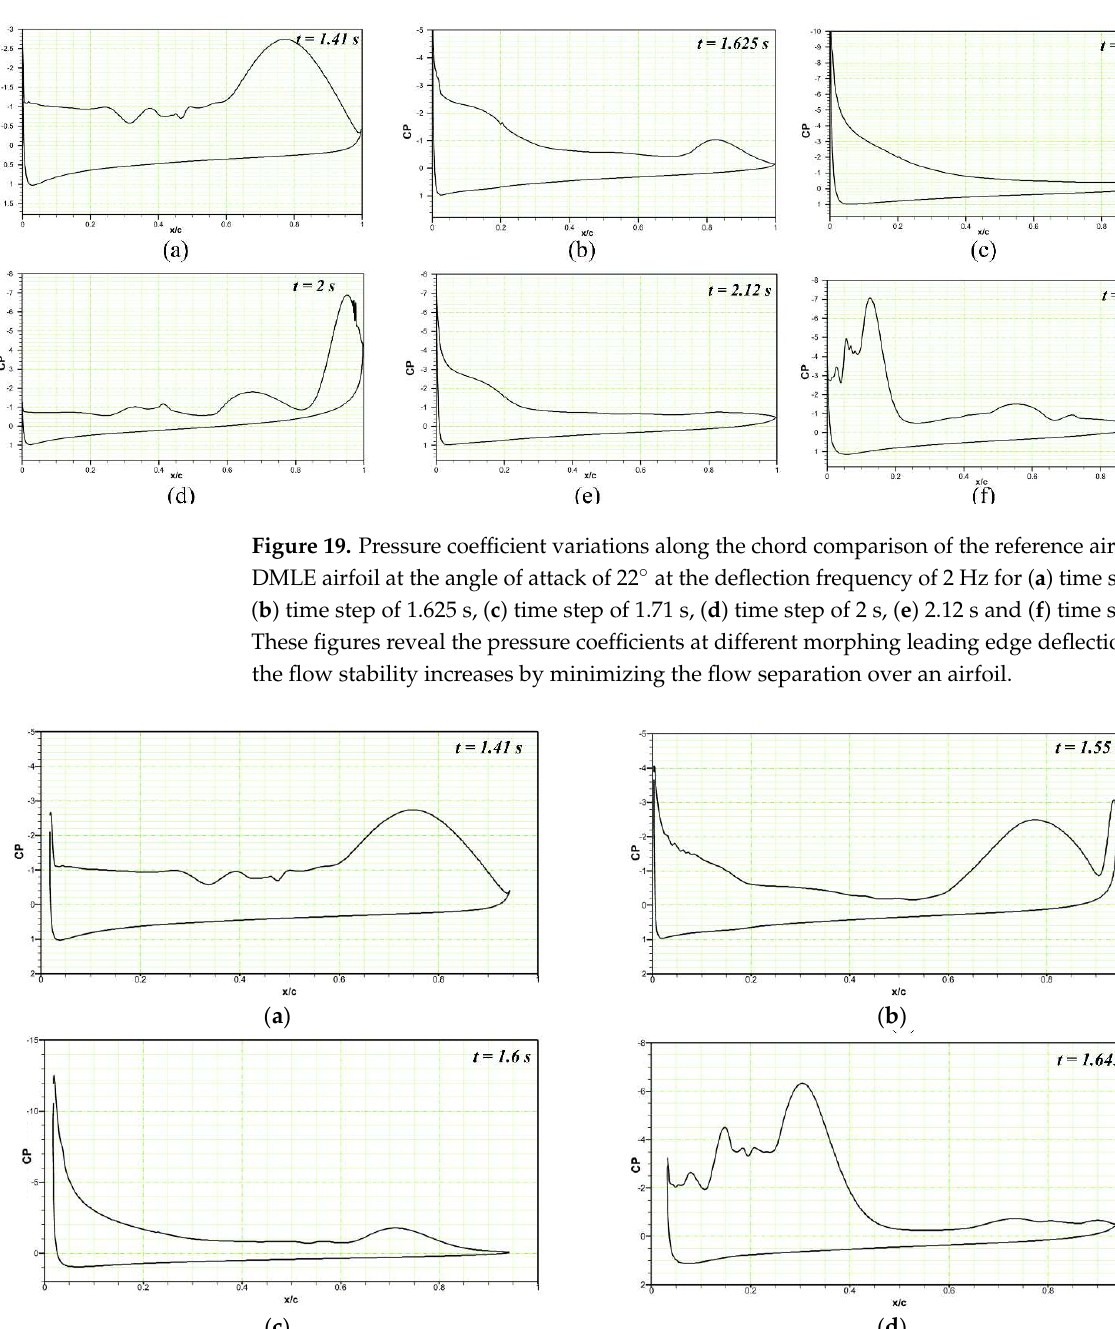
( d ) Figure 21. Pressure coefficients variations along the chord comparison of the reference airfoil with the DMLE airfoil at the angle of attack of 22 at the deflection frequency of 10 Hz for ( a ) time step of 1.41 s, ( b ) time step of 1.53 s, ( c ) time step of 1.55 s, ( d ) time step of 1.57 s. These figures reveal the pressure coefficients at different morphing leading edge deflections and also the deflection is faster at higher frequencies. To depict the vortices for the DMLE at the deflection frequency of 1 Hz and an angle of attack of 22° at different time steps, Figure 22a shows that before the starting of